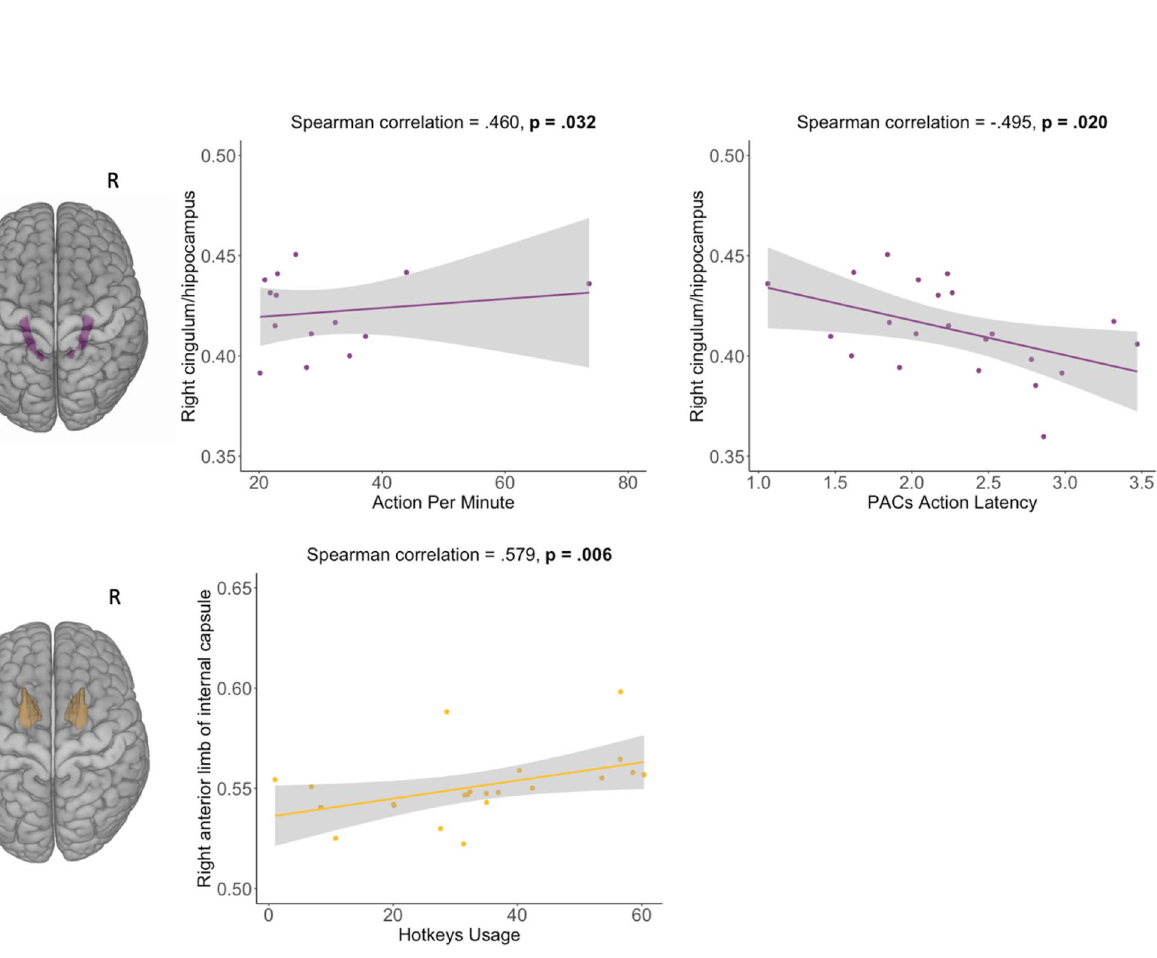
Figure 5. ROIs regions of interest, L left, R right. Predefined ROIs (right cingulum/hippocampus ( A )) and scatter plots representing the significant associations between FA values in ROIs and StarCraft II skill acquisition indicators. The purple color represents the results for cingulum/hippocampus, and yellow represents the anterior limb of the internal capsule. The results presented in the figure are without the FDR